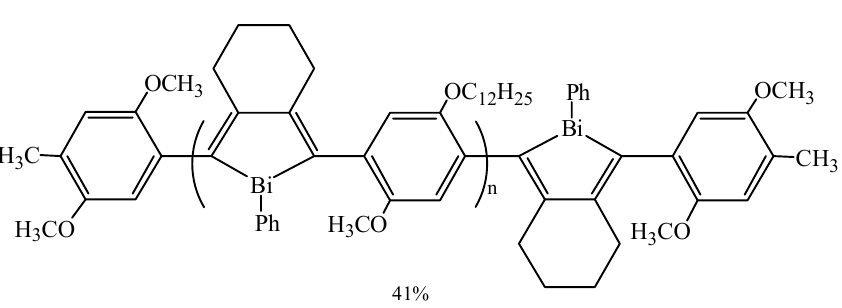
Figure 4. Bismuth-containing polymer